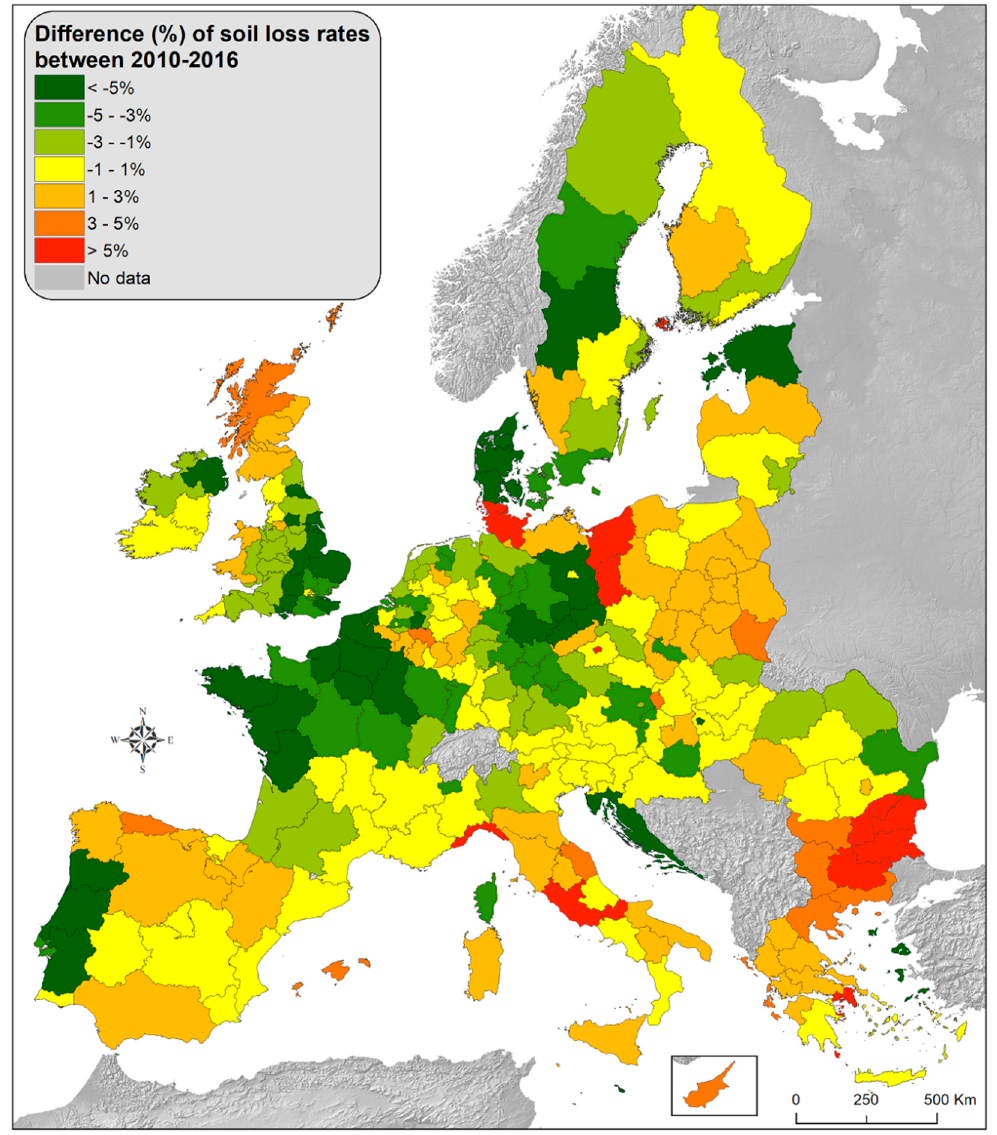
Figure 5. Progress of soil erosion indicator in the period 2010–2016.